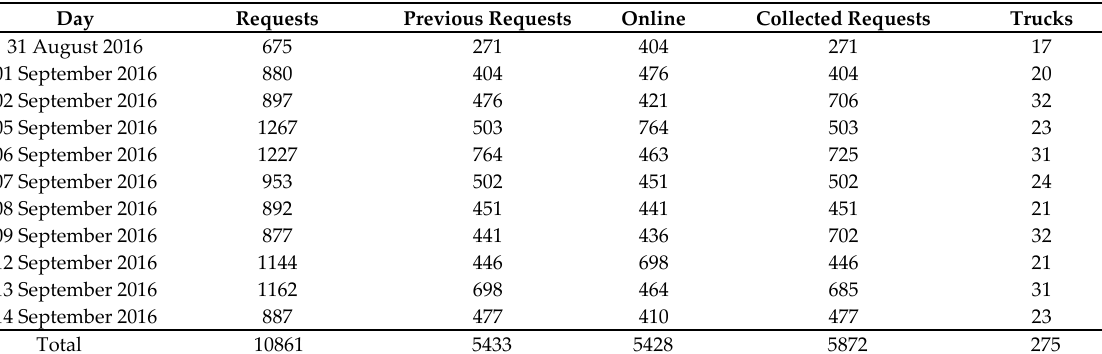
Table A2. Results obtained with Lazy strategy.